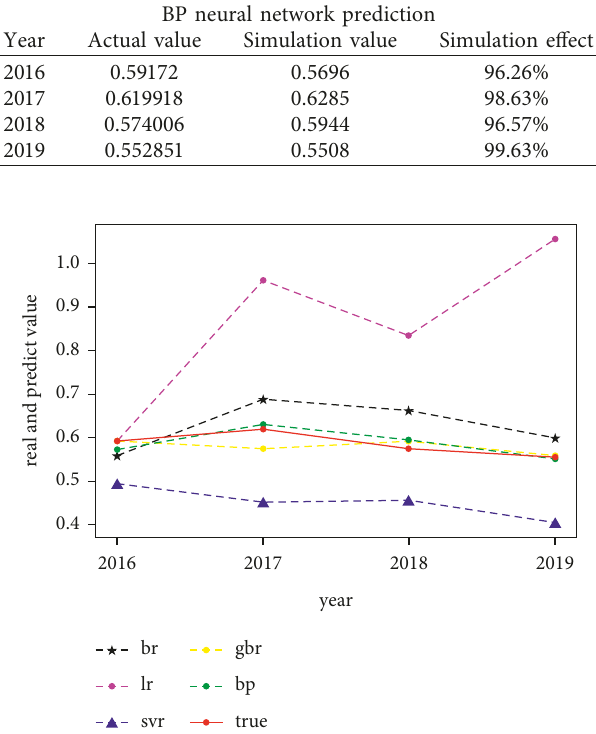
Figure 3: BP neural network training error